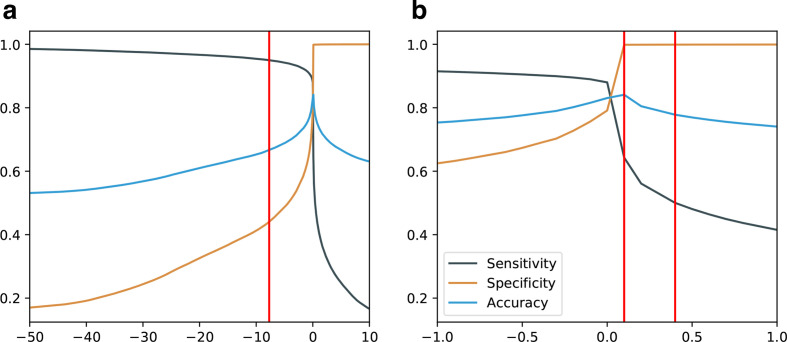
Evaluation statistics for replicon distribution score thresholds. Sensitivity, specificity and accuracy values are plotted against replicon distribution score threshold ranges. (a) Overview threshold range [−50,10]. (b) Detailed threshold range [−1,1]. Sensitivity is in black, specificity is in brown and accuracy is in blue. Red vertical lines from left to right: sensitivity threshold (−7.7), conservative threshold (0.1) and specificity threshold (0.4).